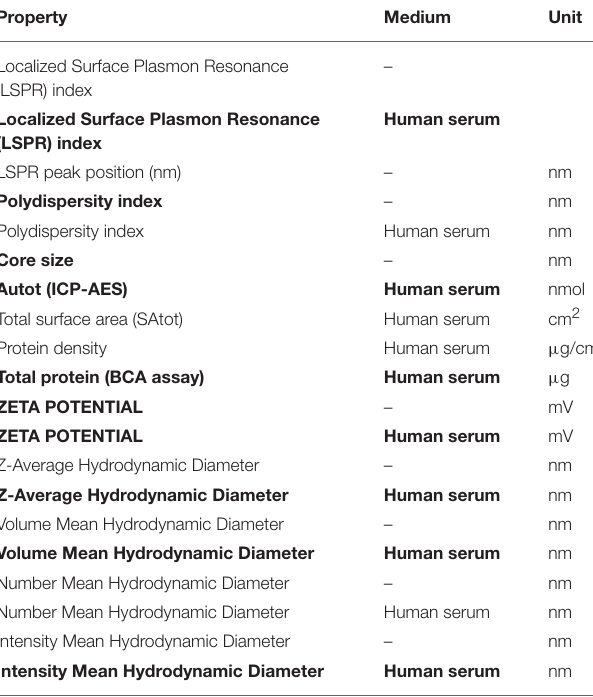
TABLE 3 | Random forest predictions with measurements outside of the 95% prediction interval (Median log2 transformed